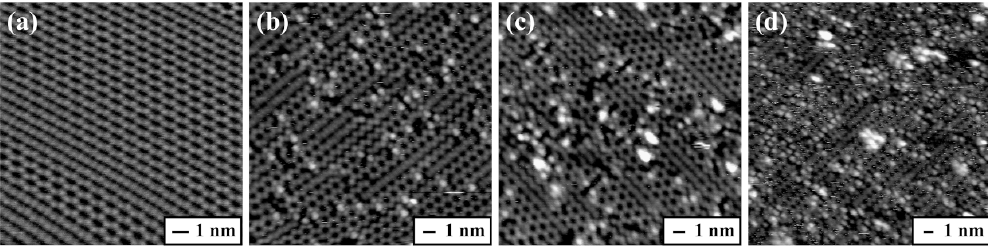
Figure 2. Representative filled-state STM images of ( a ) clean Ge(100) surface, ( b ) 0.054, ( c ) 0.083, and ( d ) 0.141 ML glycine adsorbed onto the Ge(100) surface at room temperature. The individual deposition times obtained under the same deposition conditions are ( b ) 120, ( c ) 180, and ( d ) 600 s. The adsorbed glycine on the Ge(100) surface appears as a bright protrusion in the STM images. The scan area of the STM images are ( a ) 14.1 × 14.1, ( b ) 18.6 × 18.6, ( c ) 20.0 × 20.0, and ( d ) 25.6 × 25.6 nm 2 .